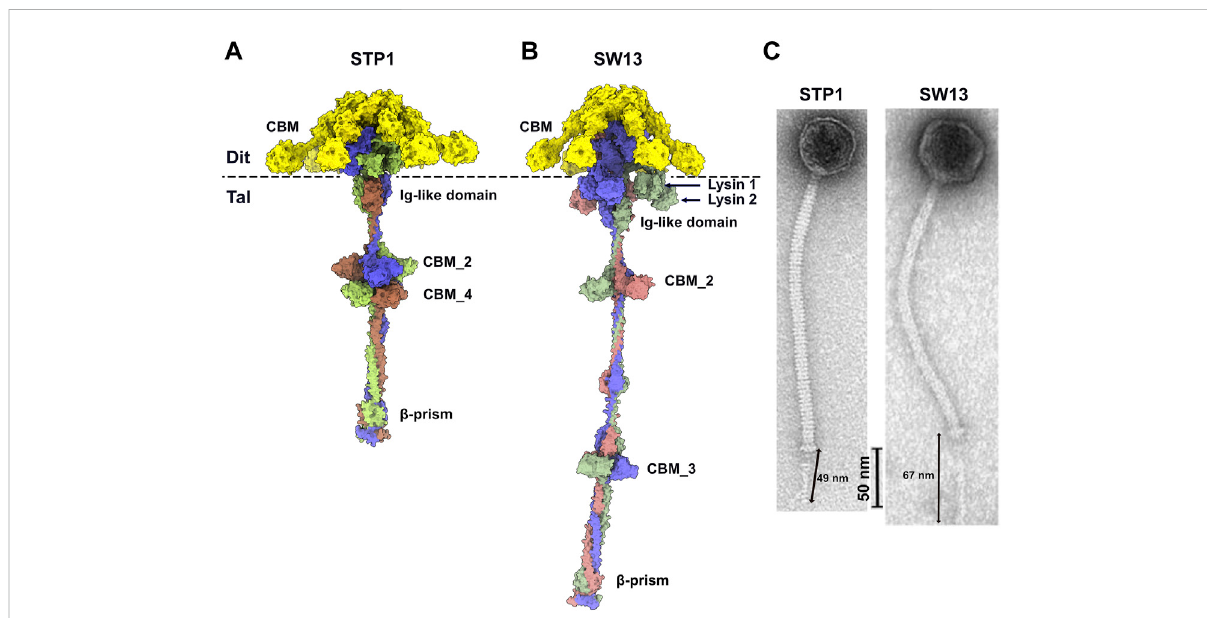
FIGURE 5 PredictedstructureofDit-TalassembliesandcomparisonwithnsEMimages. (A,B) SurfacerepresentationofphageSTP1 (A) andphageSW13 (B) Dit-Tal assembly. The Dit hexamer is colored yellow, and the Tal trimer is colored, by chain, green, salmon, and violet. (C) nsEM images of phages STP1 and SW13 (Hanemaaijer et al., 2021) with the Dit-Tal assembly length estimated to 49 and 67 nm,